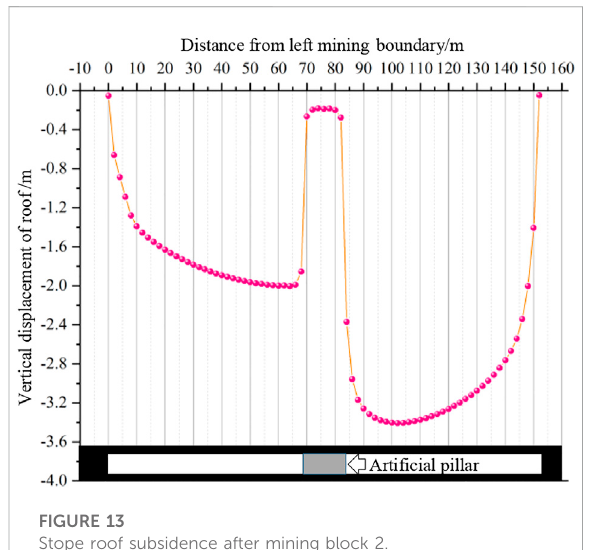
FIGURE 13 Stope roof subsidence after mining block